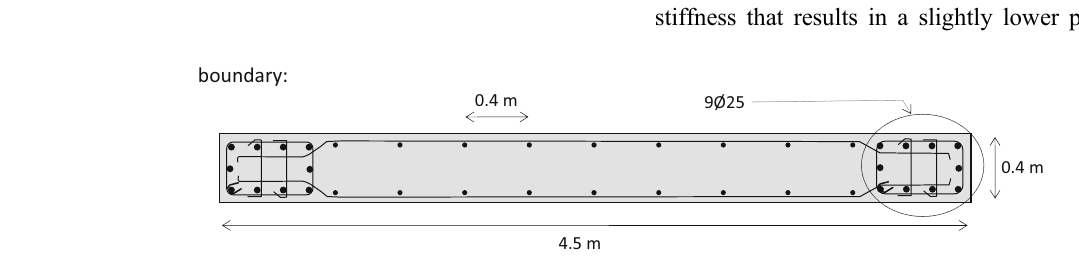
Fig. 15 Longitudinal reinforcement of the wall.